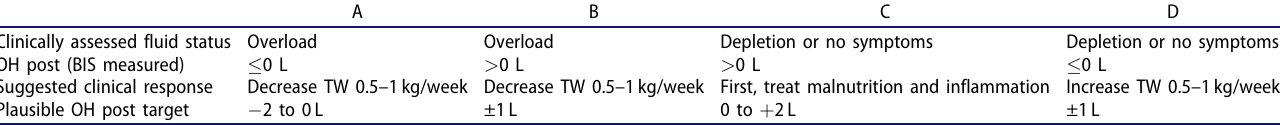
3 or 4 months, using the Body Composition Monitor (BCM,